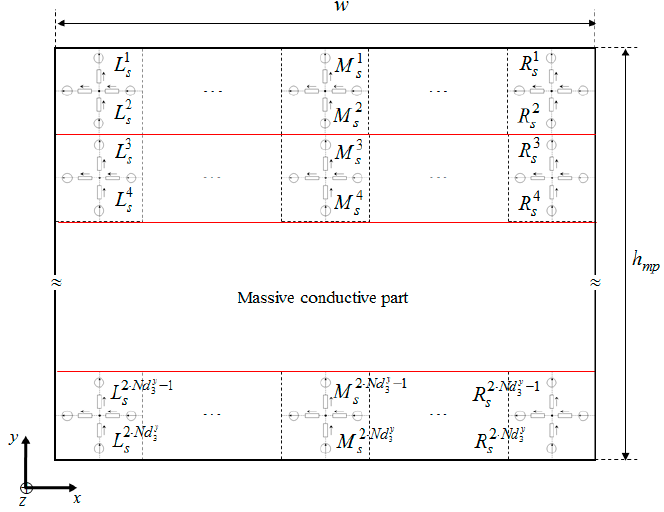
Figure 12. The values location of M l s , L l s , and R l s in the massive conductive part from the 2-D generic MEC in a ( x , y ) coordinate